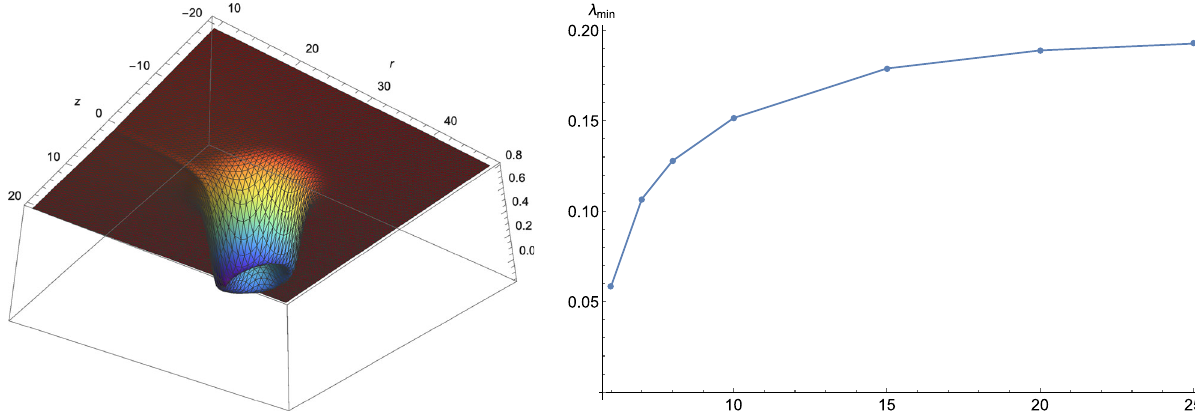
Fig. 10 Left panel: the effective potential for Z 2 perturbations following from (52). Right panel: lowest eigenvalue of linearised Schrodinger problem for Z 2 as a function of m for the solution parameters shown in Fig. 1 and Q =